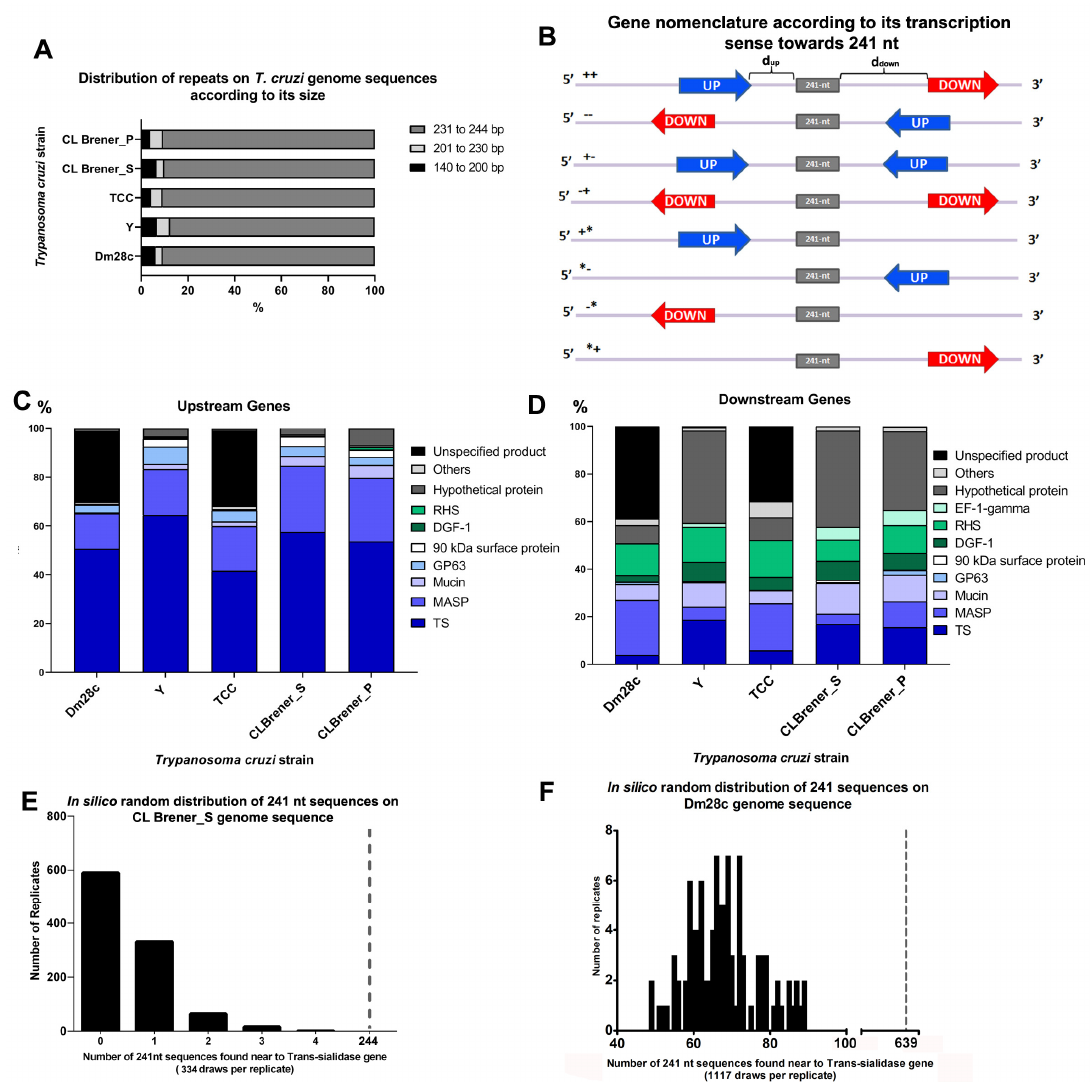
Figure 2. Localization of the 241 nt repetitive element in the T. cruzi CL Brener genome. ( A ) Consensus sequence of the 241 nt repeat that was submitted to Blast-n against the CL Brener genome, and the retrieved sequences with at least 95% identity and sizes from 140–244 nucleotides were selected. The graphic shows the frequency distribution of the retrieved sequences by their size in the genome sequence of T. cruzi strains Dm28c (TcI), Y (TcII), TCC (TcVI), and CL Brener S and P (TcVI). ( B ) Schematic representation of genes surrounding the 241 nt found inside the intergenic region. Genes were classified as upstream (UP) or downstream (DOWN) of the 241 nt repeat according to their transcription orientation. Distinct patterns of upstream and downstream genes in relation to the repeat are observed and indicated by the symbols ++ , −− , + − , − + . In some cases, only one gene is associated with the repeat and is indicated by * + , + *, * − , and − *. Letter “d” indicates the distance between the repeat and upstream (d up ) / downstream (d down ) genes. ( C ) Percentage of genes upstream and ( D ) downstream of the 241 nt repeat on the T. cruzi genome sequences of Dm28c, Y, TCC, and CL Brener strains. ( E ) A total of 334 sequences of 241 nt were randomly distributed in the CL Brener_S genome sequence. The graph shows the number of repeats found near a trans-sialidase gene. The dashed line represents the number of repeats identified close to a trans-sialidase gene in the CL Brener genome (S haplotype). ( F ) A total of 1117 sequences of 241 nt were randomly distributed in the Dm28c genome sequence. The graph shows the number of repeats found near a trans-sialidase gene. The dashed line represents the number of repeats identified close to a trans-sialidase gene in the Dm28c genome Abbreviations: TS-trans-sialidase, MASP-mucin-associated surface protein, GP-glycoprotein, DGF-1-dispersed gene family-1, RHS-retrotransposon hot spot and EF-1 γ -elongation factor-1 γ